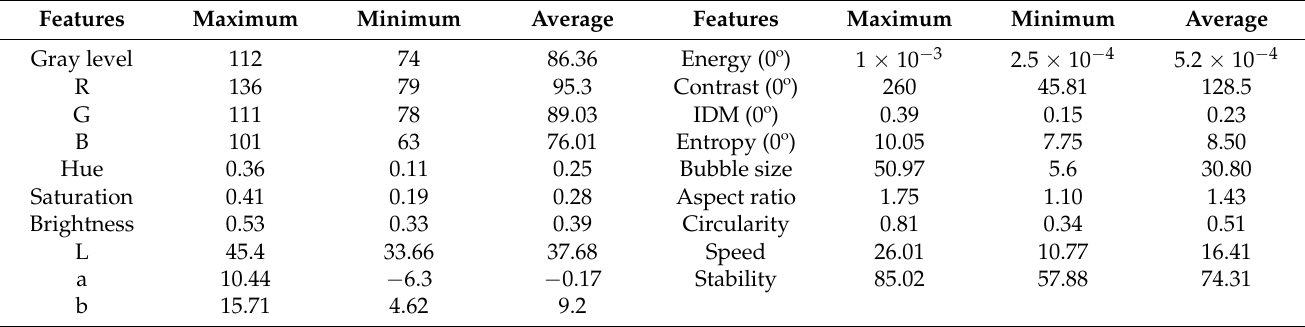
Table 3. Descriptive statistics of the froth features obtained at different operating conditions as inputs for the k-means algorithm, regression and BPNN